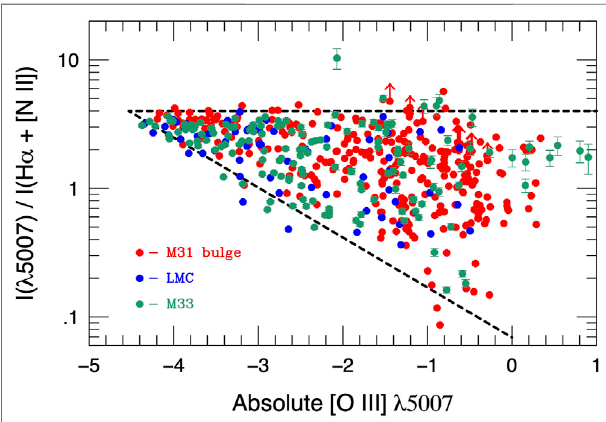
FIGURE 4 | The ratio of [O III] λ 5007 to H α +[N II] observed for PNe in M31 ’ s bulge, M33 ’ s disk, and the Large Magellanic Cloud from Ciardullo (2005). The dashed lines outline the “ cone of PNe ” de fi ned by Herrmann et al. (2008). In the top ~ 1 mag of the PNLF, [O III] λ 5007 is always much brighter than H α ; in contrast, the vast majority of H II regions and supernova remnants have H α brighter than [O